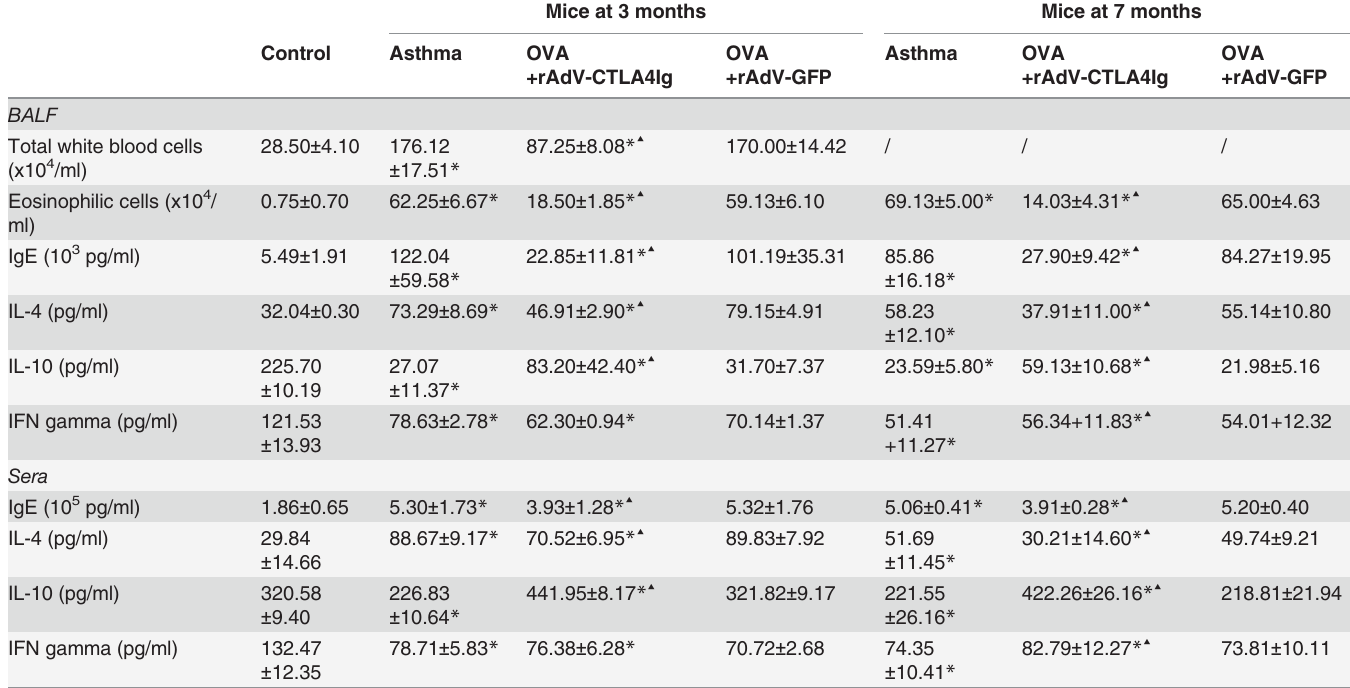
Table 1. Cell classification and changes in cytokine levels 3 and 7 months after